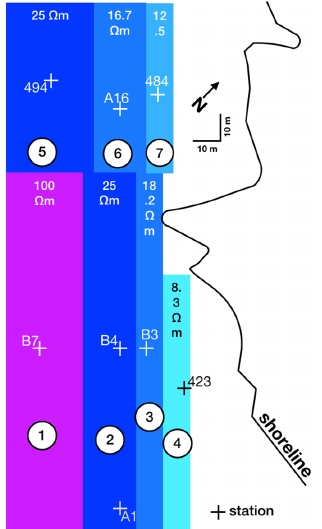
Figure A1. Illustration of the location of selected slabs (numbered 1–7) that are suggestive of a water ‐ bearing formation, and the TDEM sounding locations where the sensitivity analysis is performed. Value of unperturbed resistivity is shown for each slab.